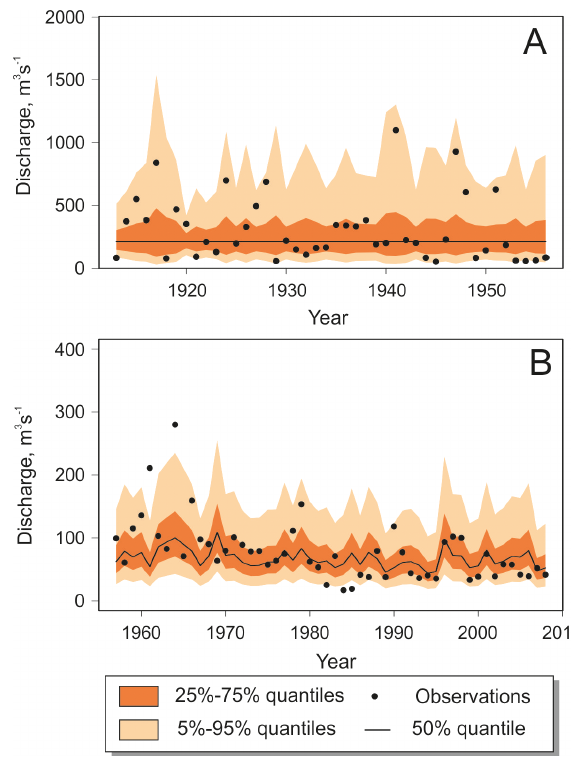
Figure 7. Modelling results of the variation in the marginal distri- butions of the annual maximum streamflow with the NAO index as the explanatory variable of the distribution parameters. (a) Quantile plot for the Aranjuez gauge in the period 1913–1956; (b) quantile plot in the period